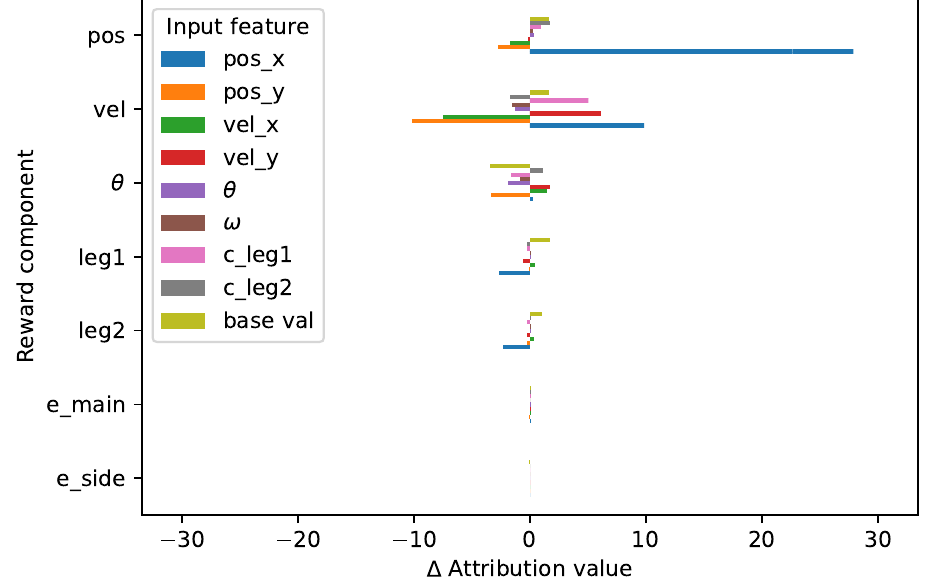
Figure A10. The contrastive explanation showing why the agent chooses fire_right instead of no_fire action on position B in Figure A6.